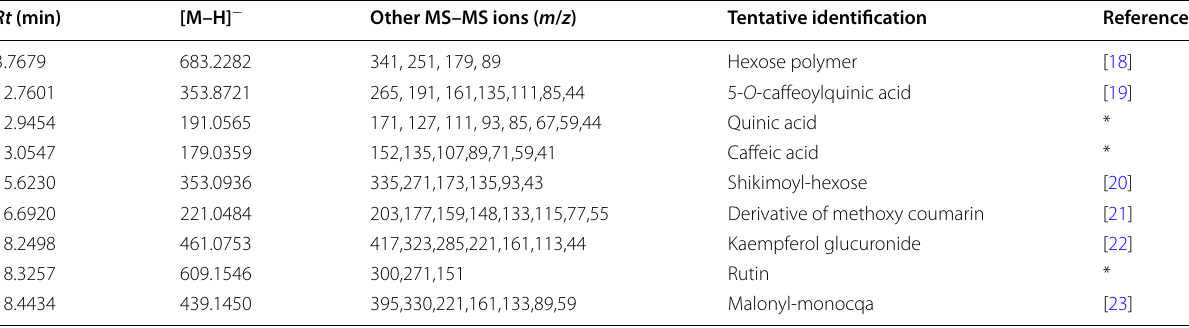
* Compounds identified by comparing retention times and MS data with those of reference compounds